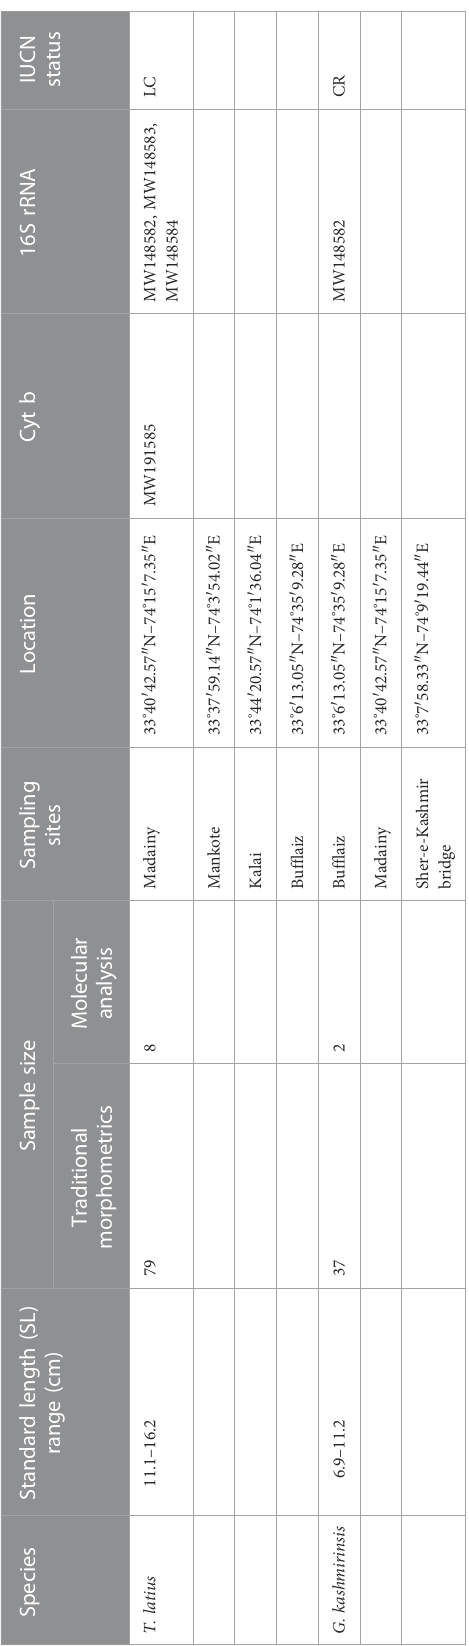
(Supplementary Figure S2) included total length (TL), standard length (SL), forked length (FL), pre-pectoral length (PpL), pre-pelvic length (ppL), pre-dorsal length (PDL), pre-anal length (PAL), pectoral fi n length (PFL), pectoral fi n height (PFH), pelvic fi n length (pFL), pelvic fi n height (pFH), dorsal fi n length (DFL), dorsal fi n height (DFH), anal fi n length (AFL), anal fi n height (AFH), caudal fi n length (CFL), caudal fi n height (CFH), head length (HL), snout length (SL), eye diameter (E-dia), pre-orbital length (PorbL), minimum body depth (MinBD), maximum body depth (MaxBD). While meristic characters were studied, including dorsal fi n rays (DFR), pectoral fi n rays (PFR), pelvic fi n rays (pFR), anal fi n rays (AFR), and caudal fi n rays (CFR). Meristic characters were counted twice by the same observer. In the current study, it was hypothesized that a working relationship exists between various growth-related morphometric parameters. The correlation coef fi cient “ r ” was determined among all the characteristics. T A